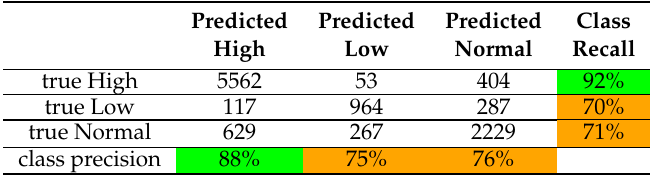
Table 2. Confusion matrix for KNN.